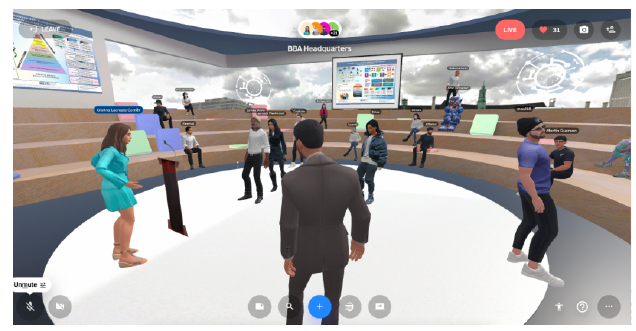
Figure 21: The British Blockchain Association’s Member Forum at the BBA’s Metaverse Headquarters